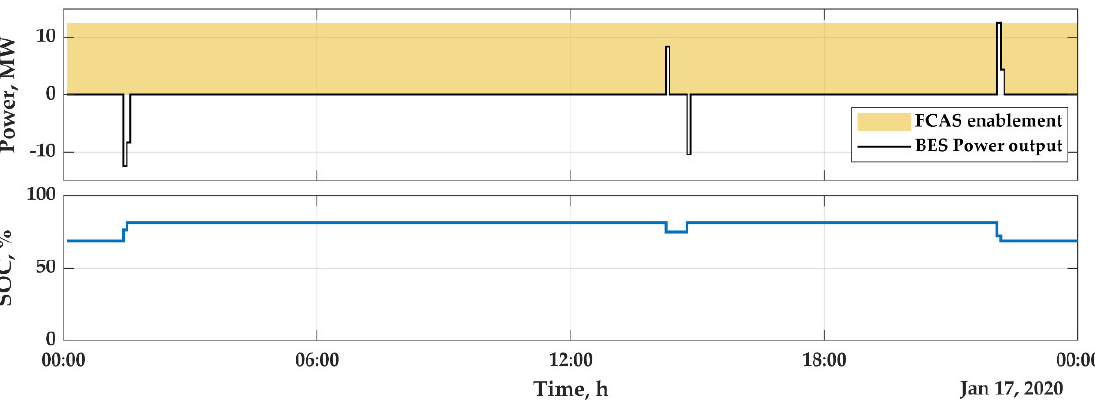
Figure 11. Battery charge and discharge actions and FCAS enablement ( top ) and resulting SOC ( bottom ) under Strategy 3